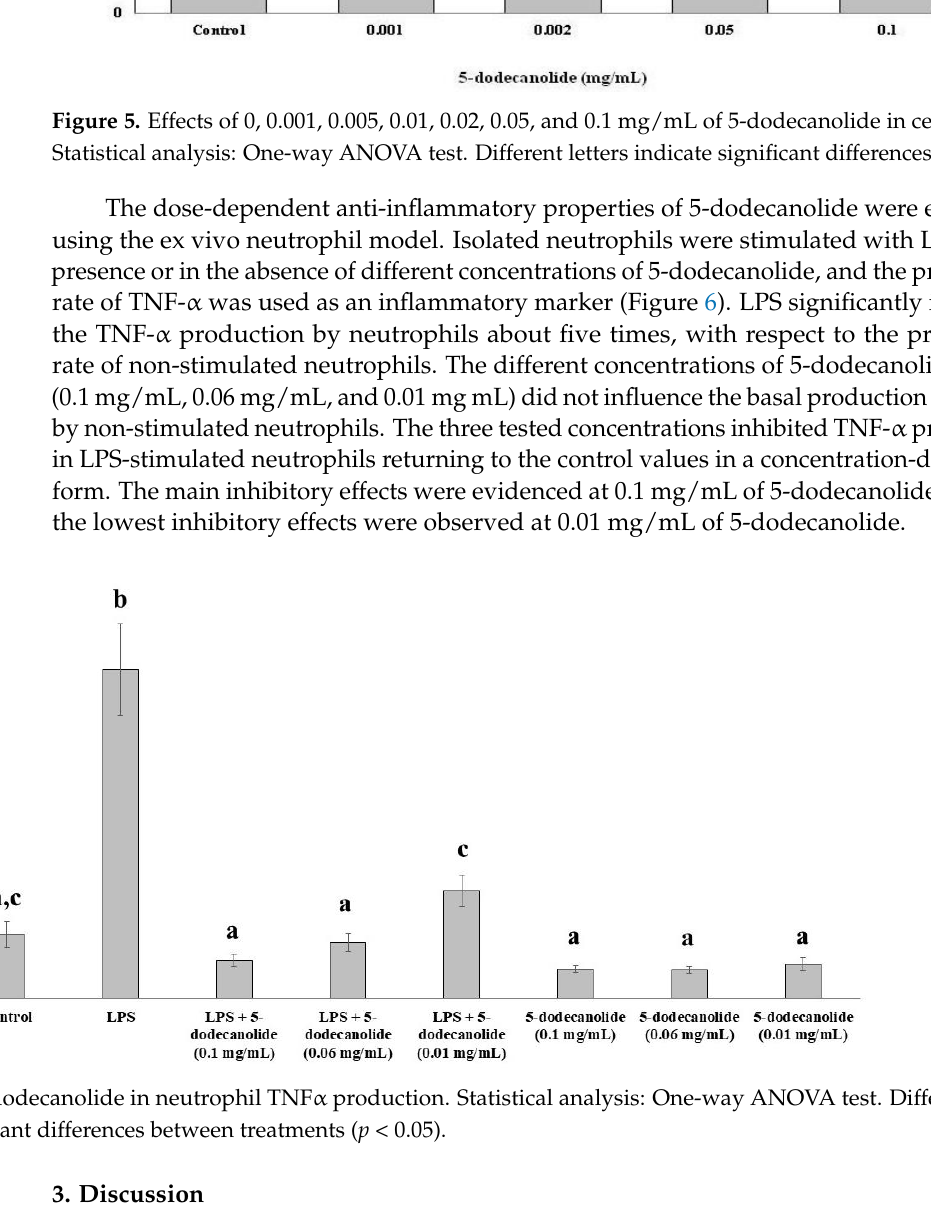
Figure 5. Effects of 0, 0.001, 0.005, 0.01, 0.02, 0.05, and 0.1 mg/mL of 5-dodecanolide in cell viability.